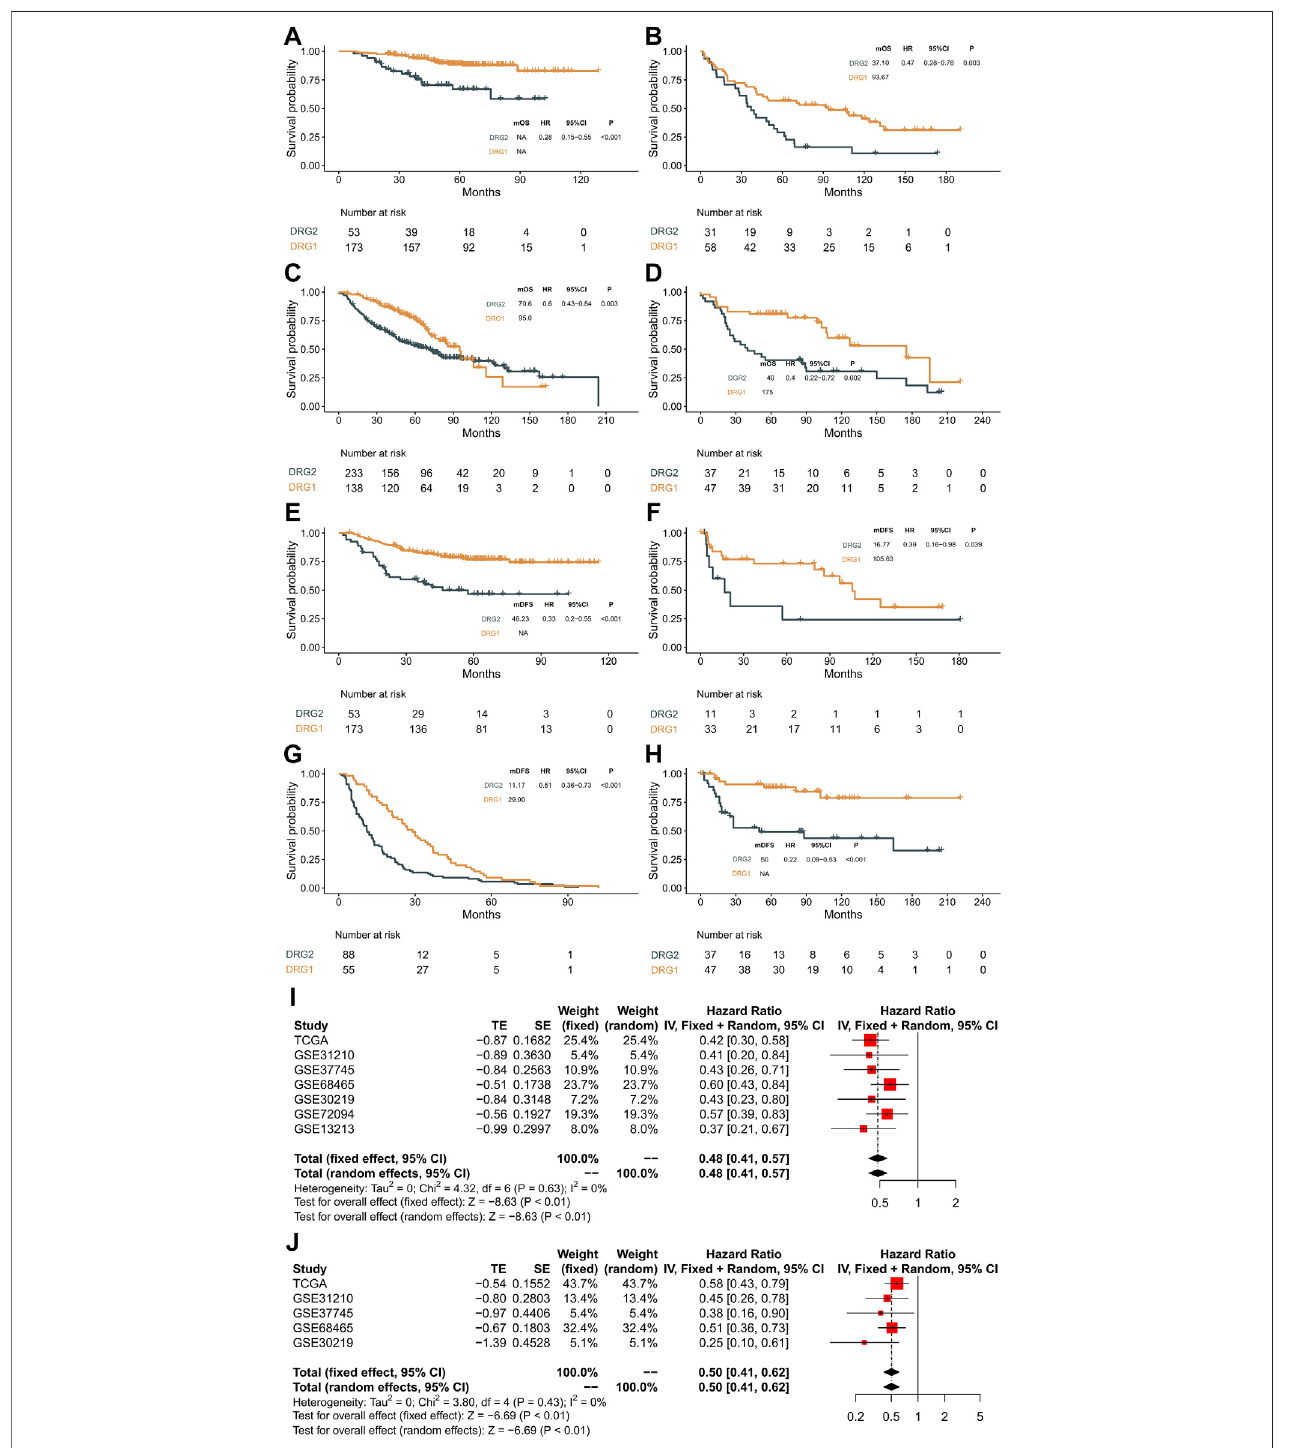
FIGURE 4 | Validation in the GEO datasets and meta-analysis. (A – D) Kaplan – Meier curves showing overall survival between DRG1 (yellow) and DRG2 (gray) in GSE31210,GSE37745,GSE68465,andGSE30219. (E – H) Kaplan – Meiercurvesshowingdisease-freesurvivalbetweenDRG1(yellow)andDRG2(gray)inGSE31210, GSE37745, GSE68465, and GSE30219. (I) Pooled estimates of overall survival. (J) Pooled estimates of disease-free survival.